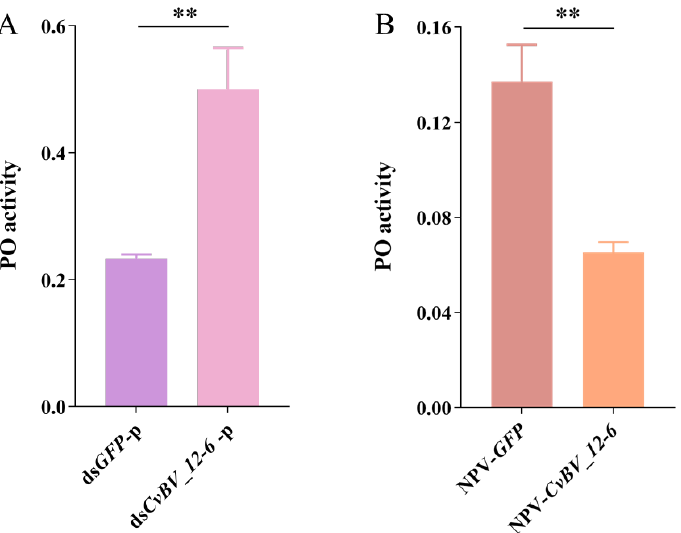
Figure 5. CvBV_12-6 inhibited the melanization response of the P. xylostella host. ( A ) One microgram of ds CvBV_12-6 or ds GFP was injected into third instar P. xylostella larvae, and parasitization was performed immediately. The hemolymph was collected, and the PO activity was measured 24 h pp. ( B ) NPV- CvBV_12-6 or NPV- GFP was injected into third instar P. xylostella larvae, and the PO activity was measured 24 h post injection. Data are presented as the mean ± SD. Differences among samples were evaluated for significance via Tukey’s test (** , significant difference at a p value < 0.01).